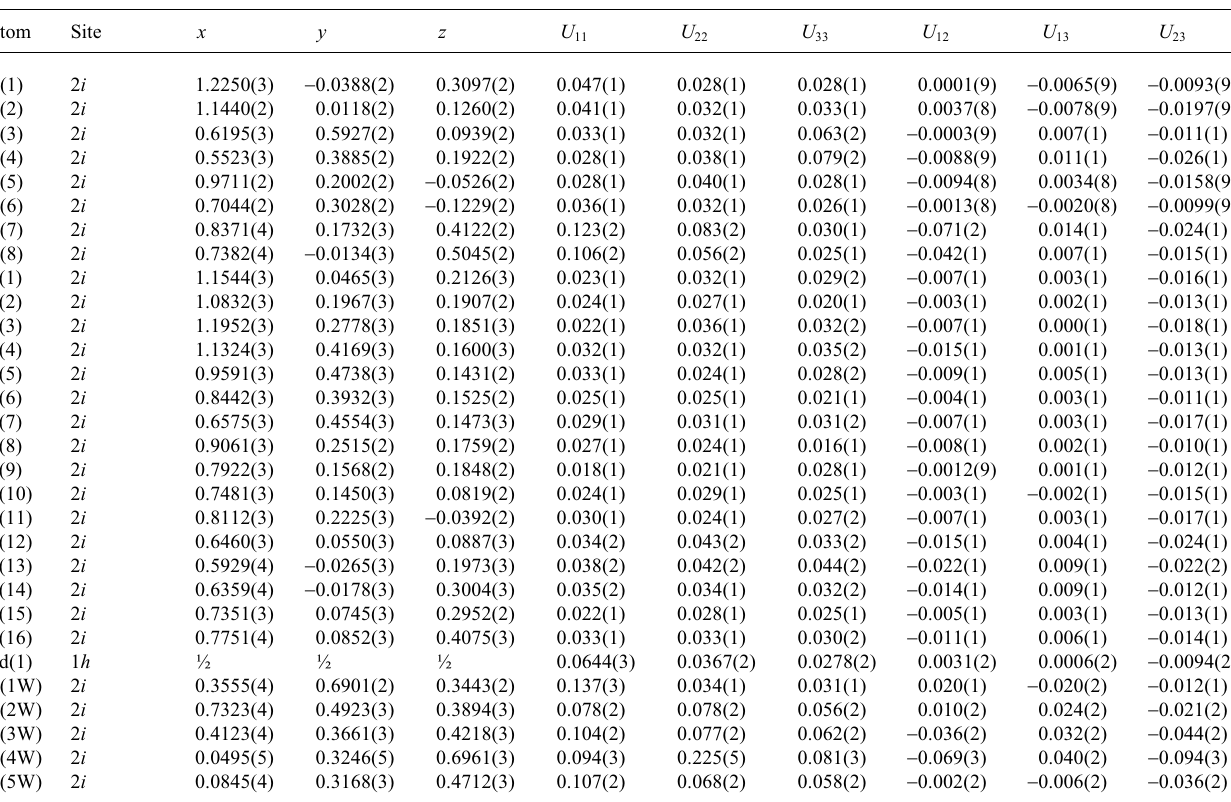
Table 3. Atomic coordinates and displacement parameters (in Å 2 ).